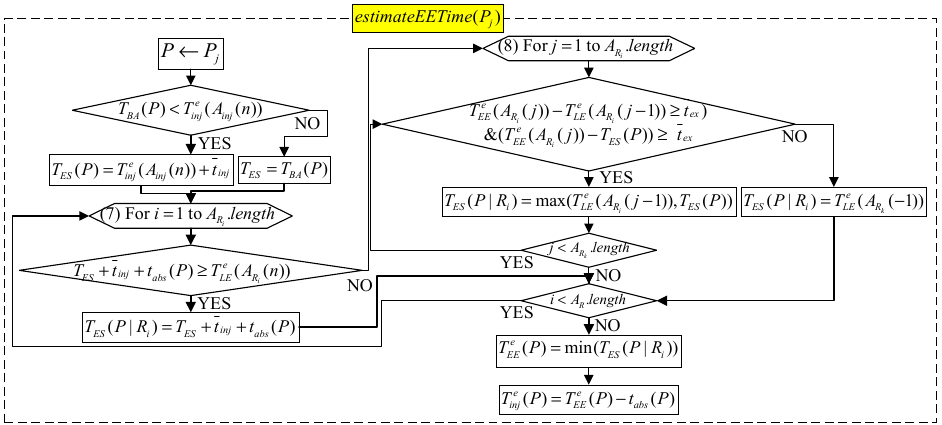
Figure 18. Flow chart for estimating injection time and scan time.